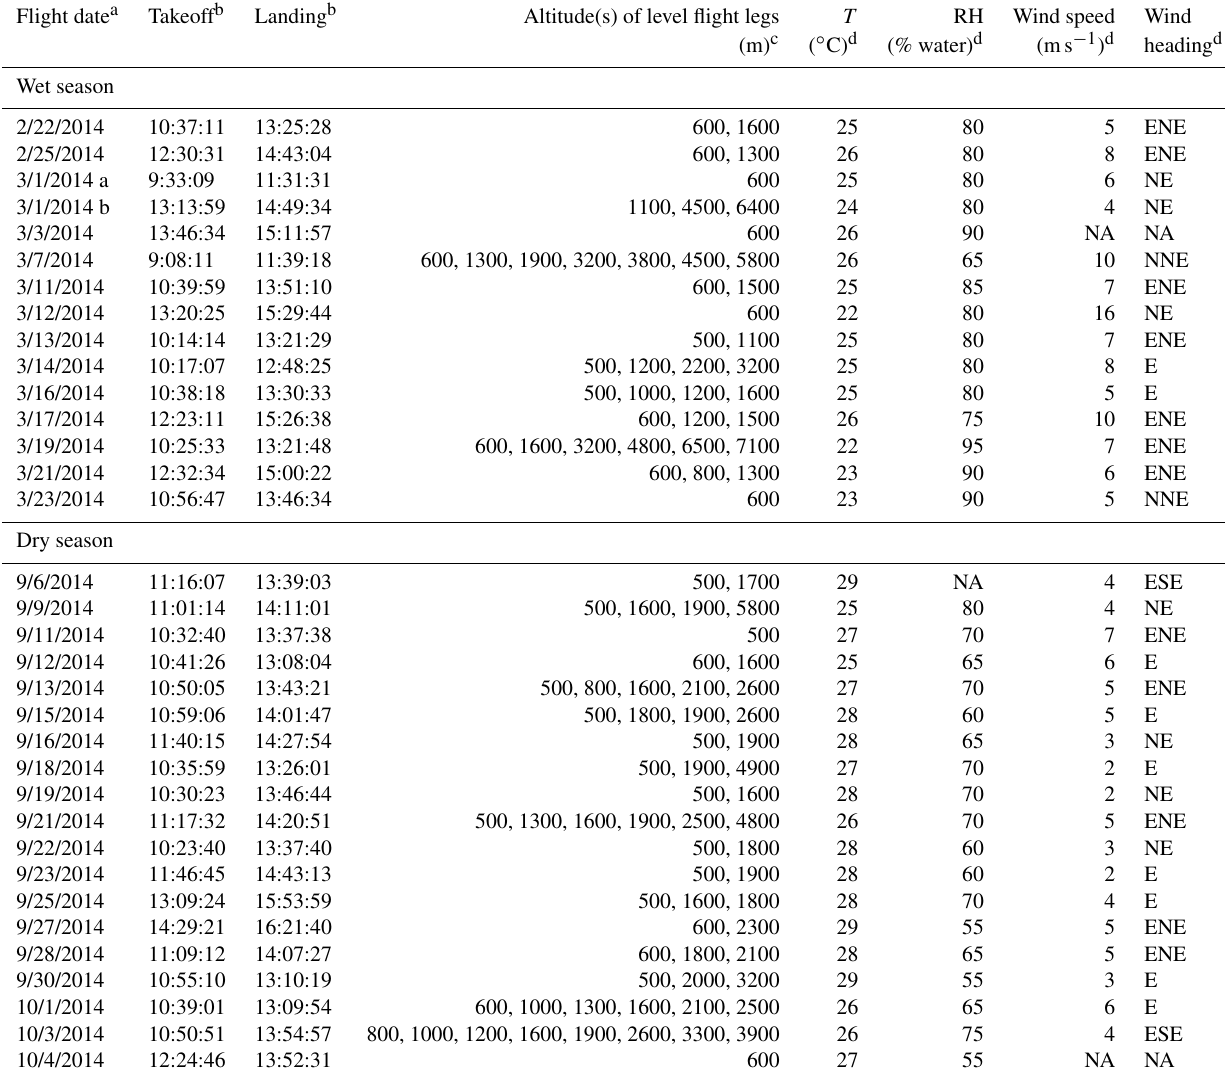
Table 1. Flight times, altitudes of level legs, and meteorological parameters measured by instrumentation on board the G-1 aircraft for research flights described in this paper. Temperature, RH, wind speed, and wind heading correspond to values measured shortly after takeoff at altitudes less than 1000m. Note that meteorological parameters are not homogeneous in space or time. Date format: month/day/year. Flight date